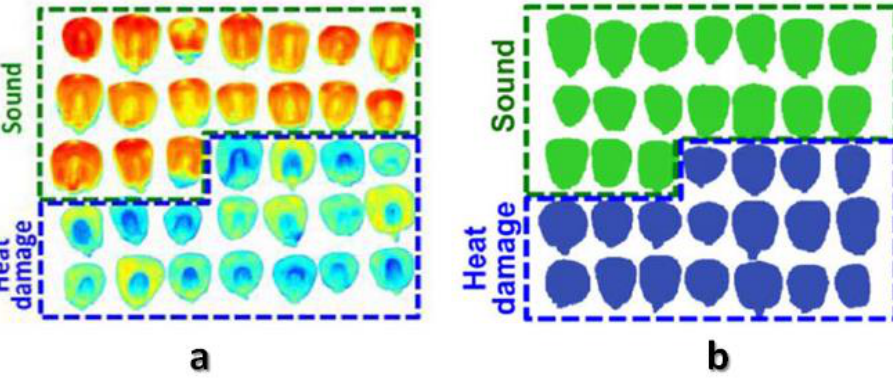
Figure 8. Defect detection on maize kernels ( a ) PCA scores image showing the clear separation between heat damage class and sound class maize, ( b ) classification image resulting form PLS-DA for discrimination between heat damage class and sound class maize kernels (adapted from Sendin et al. [43]).